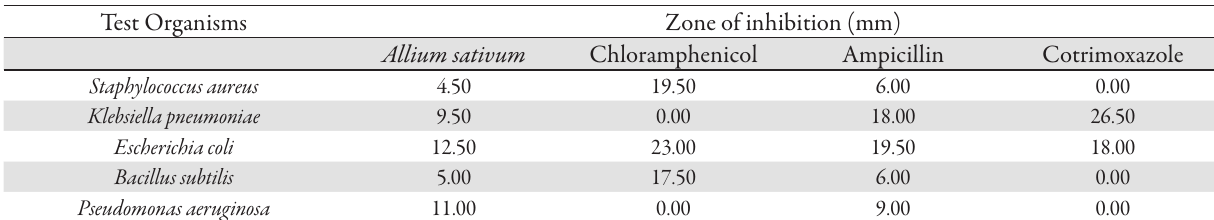
Tab. 6. Comparison of the antimicrobial efficacy of the ethanolic extracts of Allium sativum with standard antibiotics Test